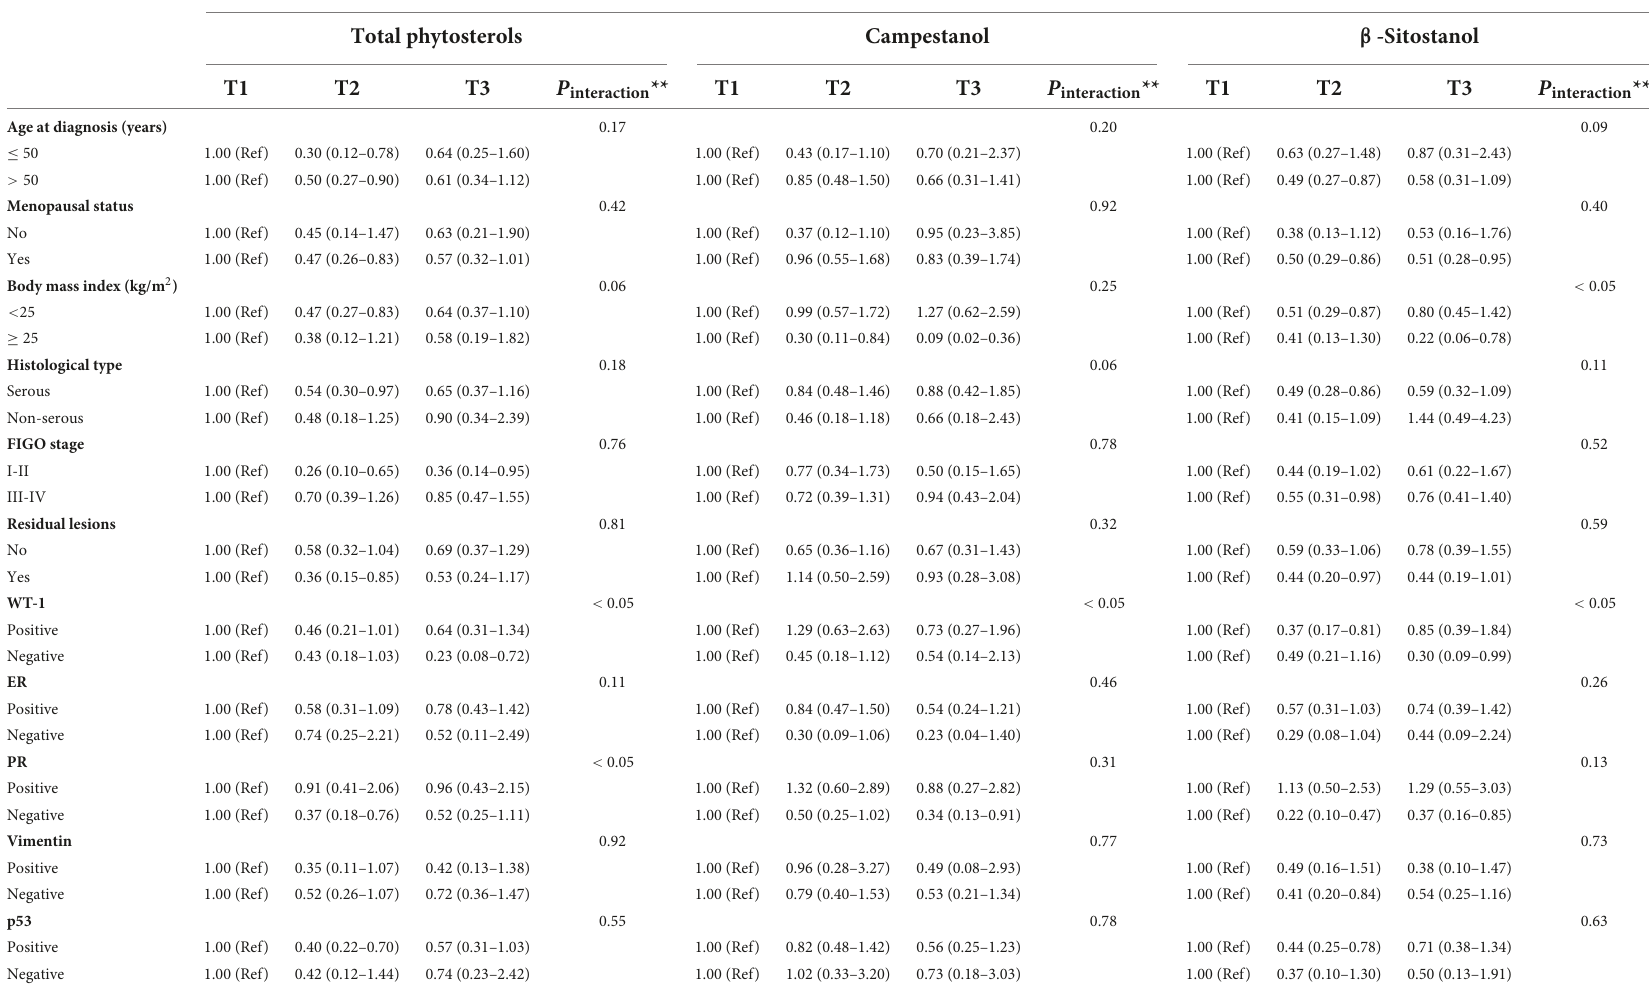
TABLE 3 Subgroup analyses of demographical, clinical, and immunohistochemical characteristics for adjusted hazard ratio (HR) and 95% confidence interval (CI) for the associations of total phytosterols, campestanol, and β -sitostanol intake with overall survival among ovarian cancer